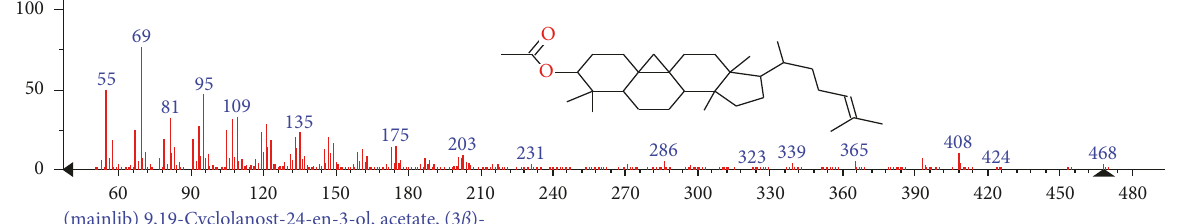
Figure 65: Mass spectrum of compound 9,19-cyclolanost-24-en-3-ol, acetate, (3 β )- of whole plant hexane fraction of Achillea wilhelmsii (WHFAW).